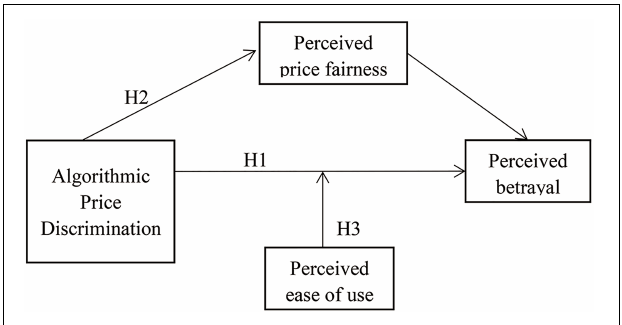
FIGURE 1 | The theoretical framework of this research.